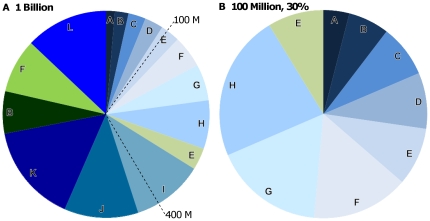
Distribution of an annual budget (e.g., US $1 B, $400 M, and $100 M) to the highest ranking ecoactions.Funding is distributed to all available reef and land habitat (a) and restricted to 30% of available habitat (b) under scenario 1 (management costs). Shades of green and blue represent funding to land- and sea-based conservation, respectively. Letters correspond to ecoregion labels in Figure 2a.